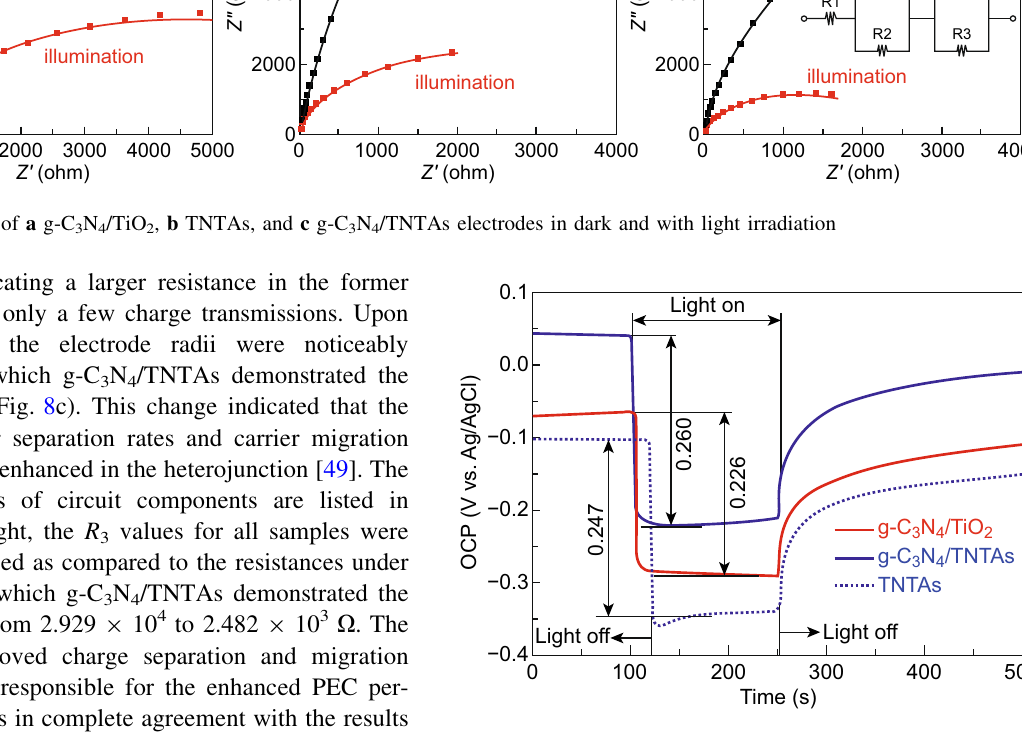
Fig. 9 Transient OCPs of g-C 3 N 4 /TNTAs, TNTAs, and g-C 3 N 4 /TiO 2